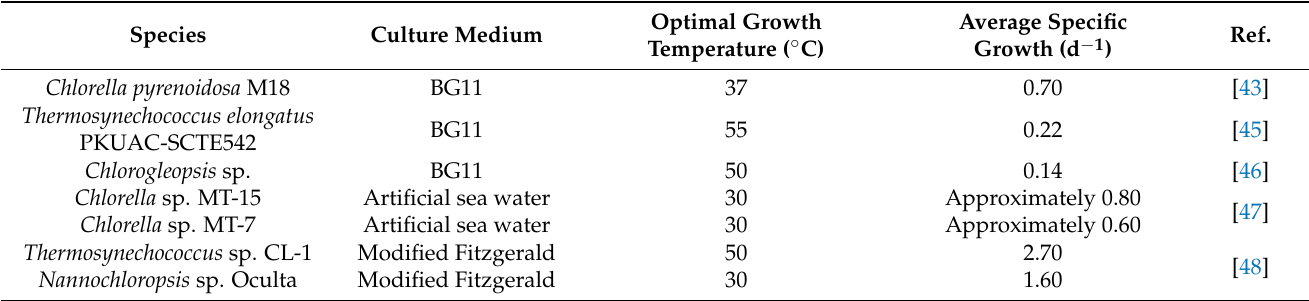
Table 1. The optimal growth temperature for different species of